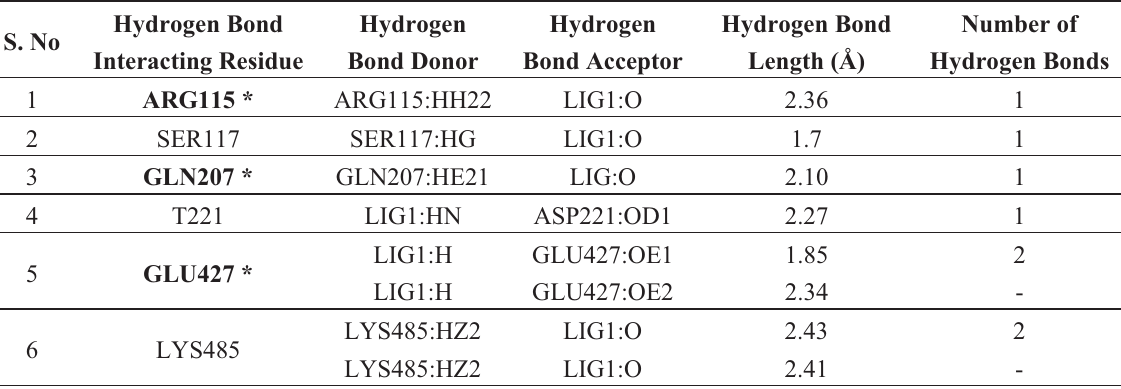
Table 1. Hydrogen bond interaction results for B. oleracea MYR–sinigrin.